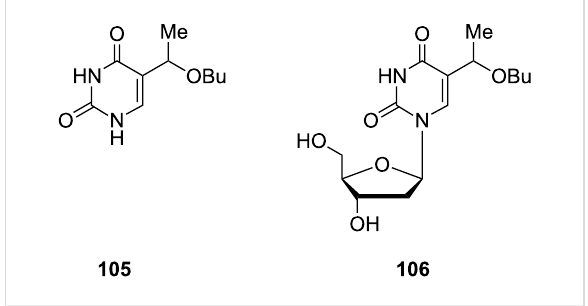
Figure 7: 5-(1-Butoxyethyl)uracil 105 and 5-(1-butoxyethyl)-2'- deoxyuridine ( 106 ).